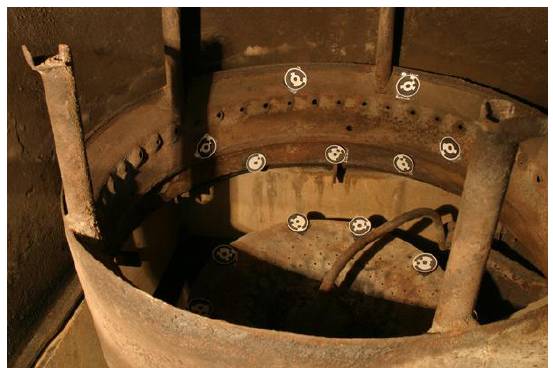
Figure 5. Boiler with coded